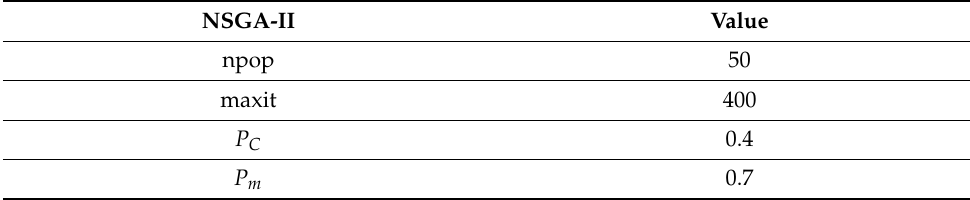
Table 3. Parameters for